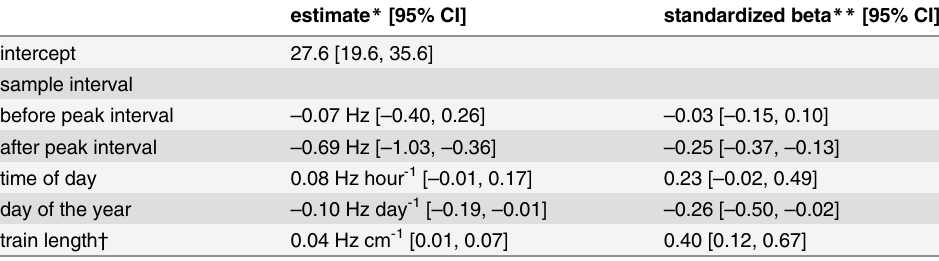
Table 2. LMEM to predict peacock train-rattling vibration frequency ( n = 104 observations of 35 dis- plays by 12 adult males).